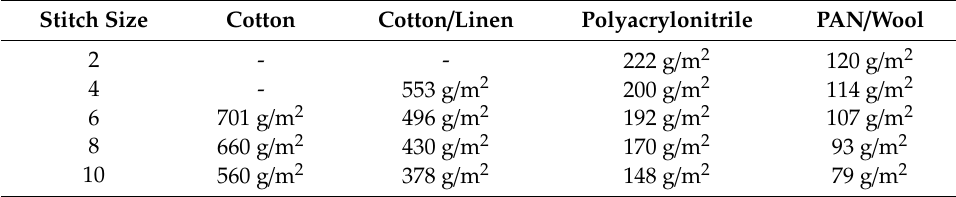
Table 2. Areal weights of knitted fabrics under examination in this study.